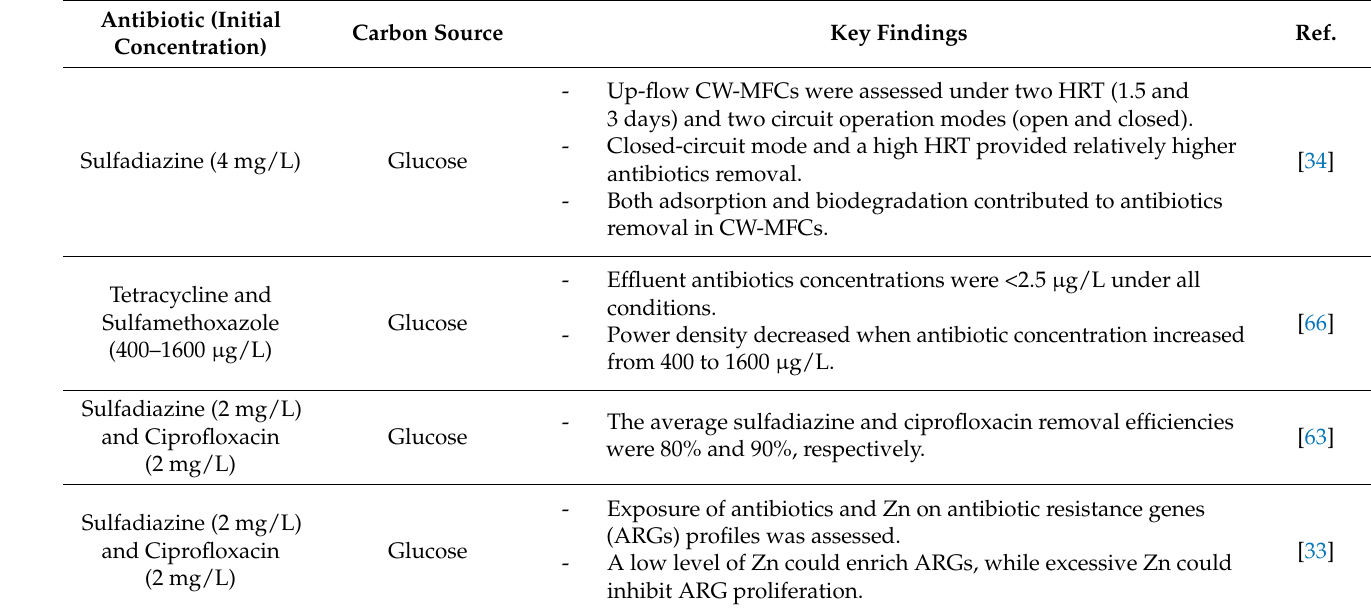
Table 2. Summary of studies related to constructed wetland coupled with microbial fuel cell (CW- MFC) for antibiotics removal from